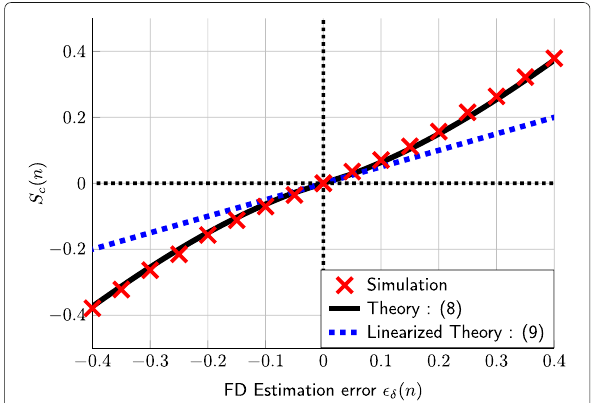
Fig. 4 Theoretical, simulated and linearized S-curve versus the FD estimation error